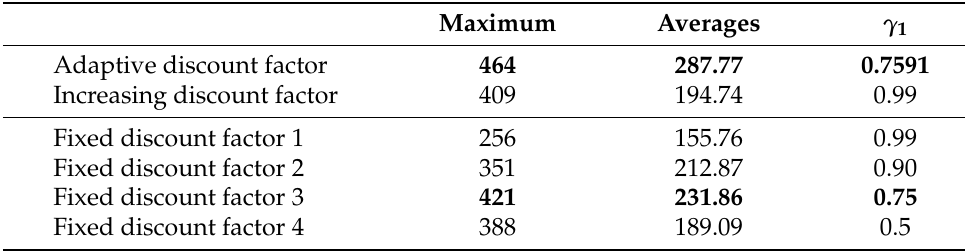
Figure 15. Adjustment of discount factor in continuing path planning task. Table 4. Comparison of performance in continuing path planning